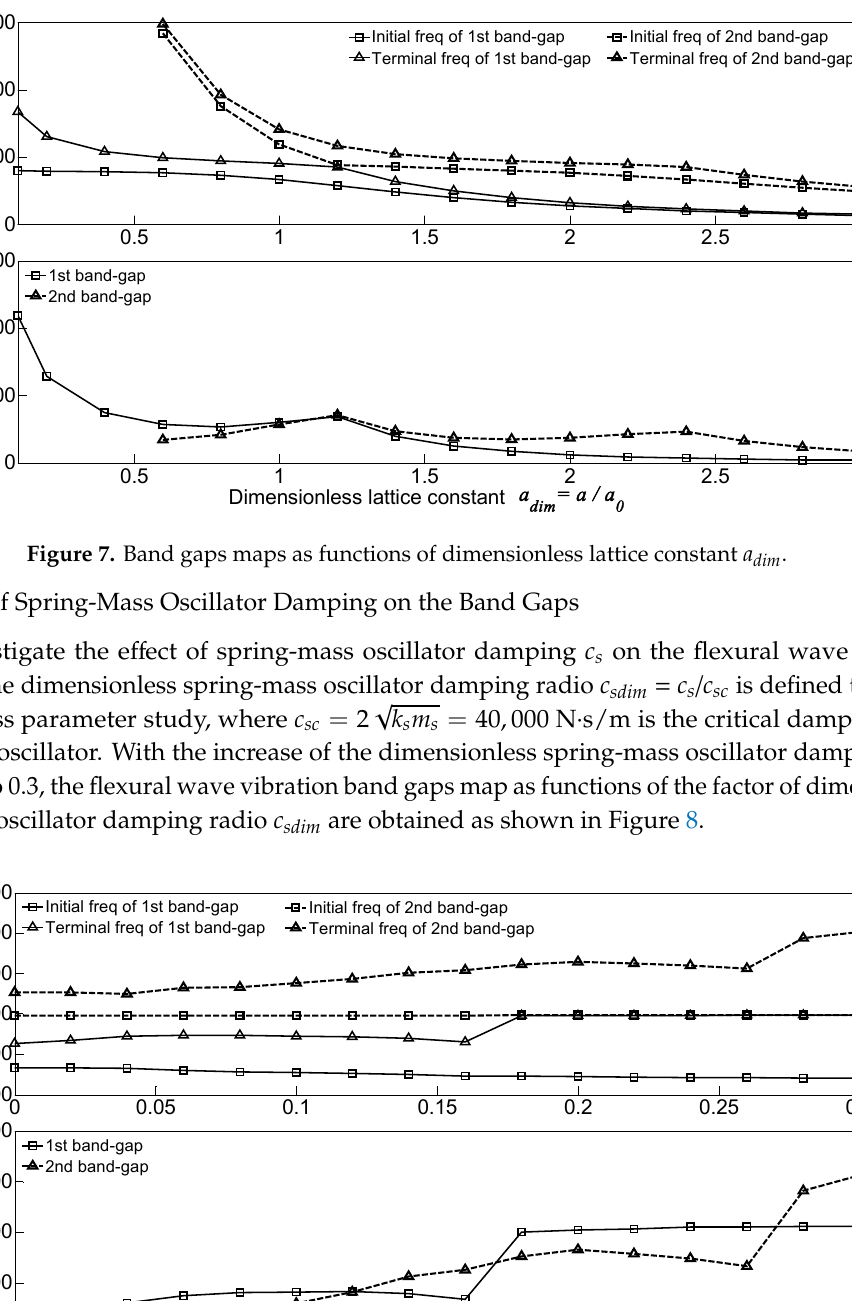
Figure 8. Band gaps maps as functions of dimensionless spring-mass oscillator damping radio c sdim.